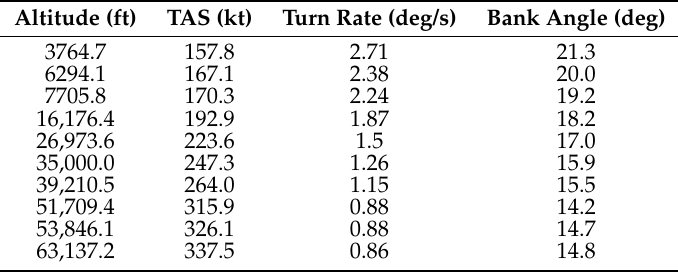
Table 5. Global Hawk turn rates and bank angles for Mission